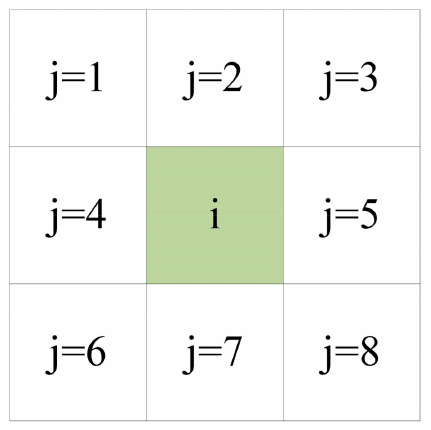
Figure 3. Illustration of the 3 × 3 matrix arrangement where the degree of conflict around a cell (i =